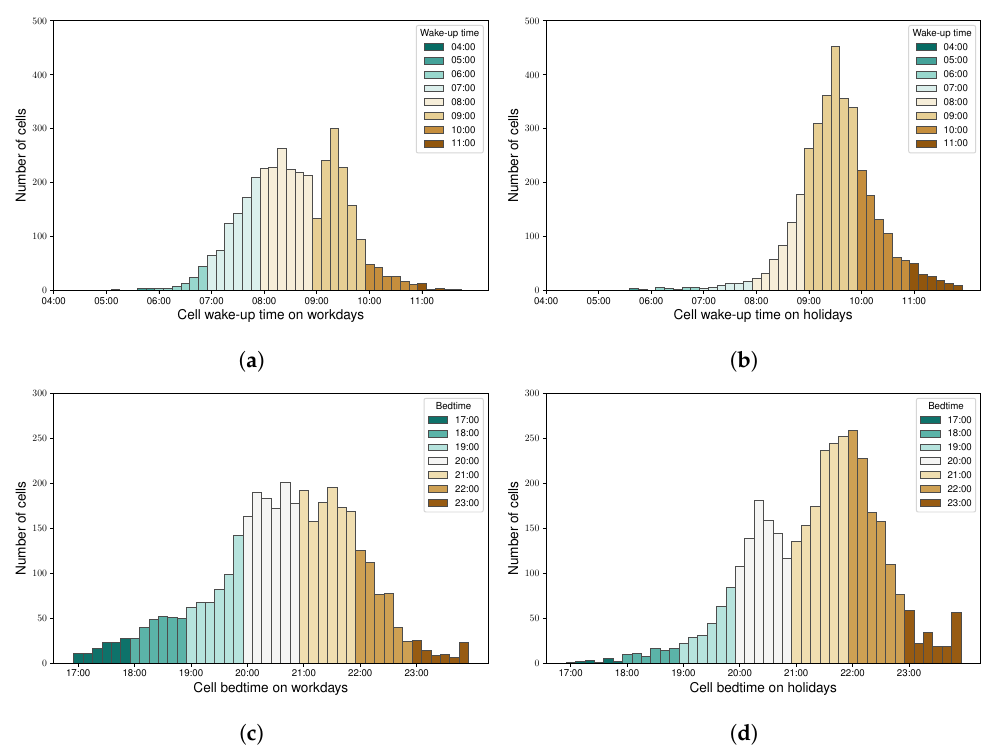
Figure 12. Cell based wake-up time ( a , b ) and bedtime ( c , d ) distribution for workdays and holidays, respectively, in the “April 2017”